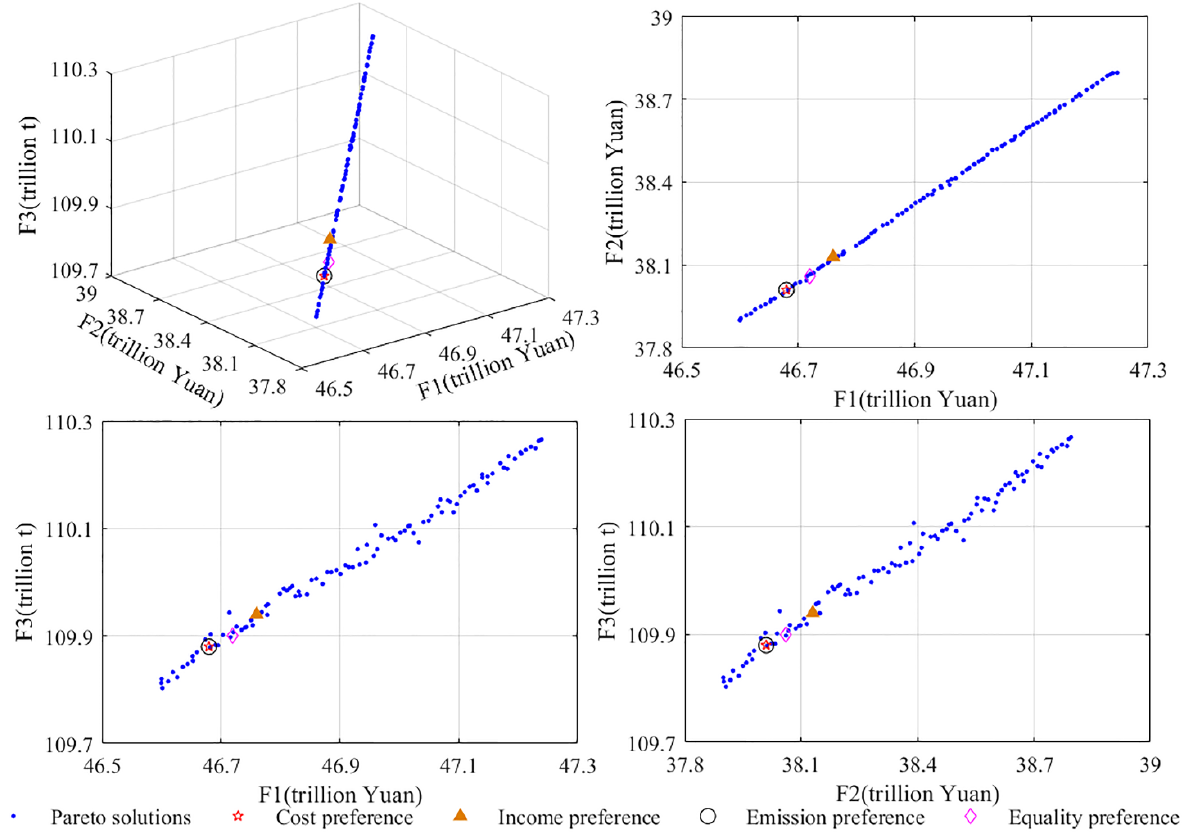
Figure 4. Pareto Front and Selected Solutions.